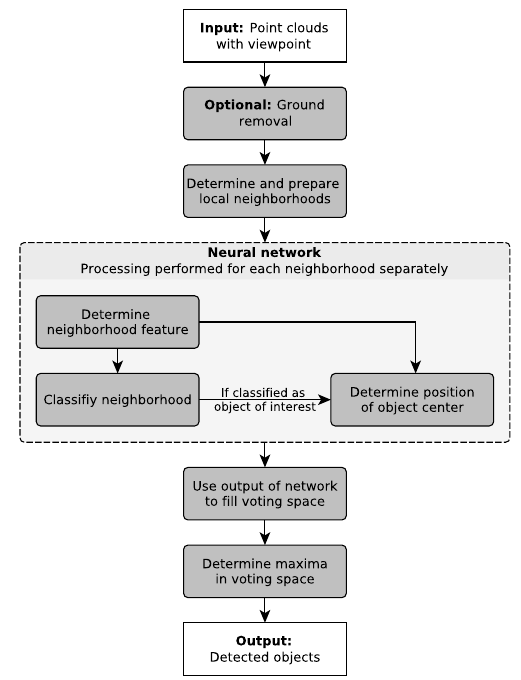
Figure 1. Main processing steps of our approach for detection of